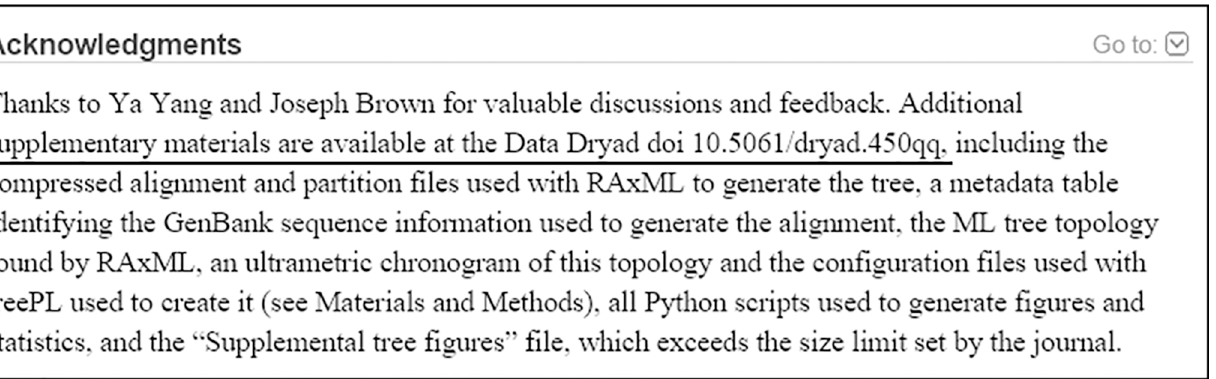
Fig 2. Example of the PubMed Central Acknowledgments where the authors have indicated the deposit of data in a specific repository; PMCID: PMC4085032.